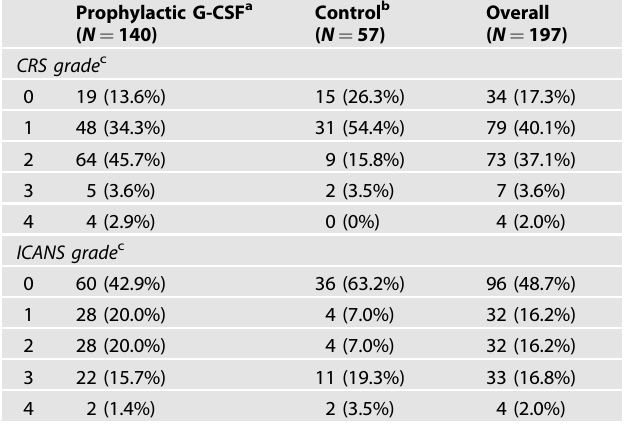
Table 3. Maximum CRS and ICANS in lymphoma cohort.